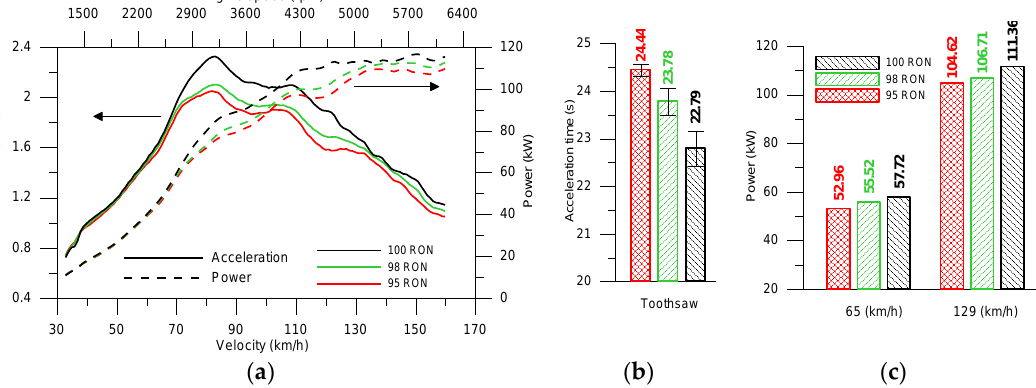
Figure 3. ( a ) Acceleration and power output along the toothsaw, ( b ) total acceleration time for toothsaw and ( c ) power output for steady-state modes.